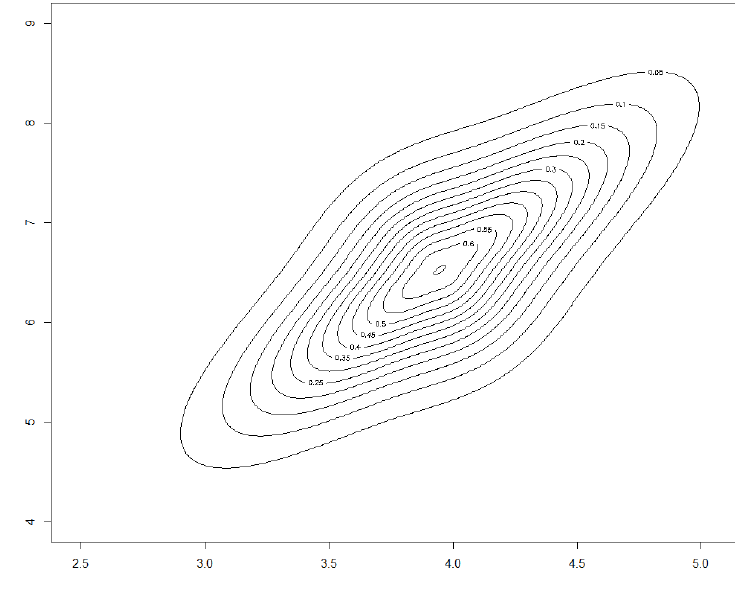
Figure 10: contour plot of the density.